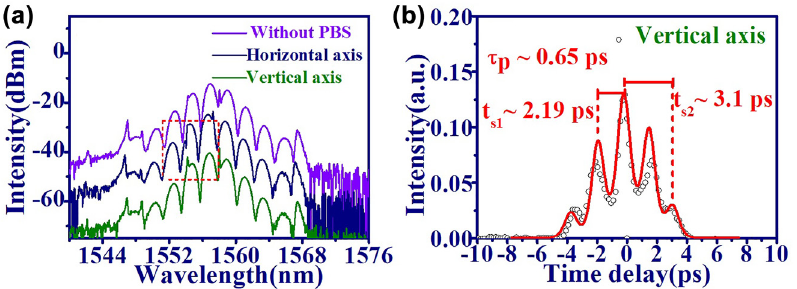
Figure 6: Bound GVLVSs from EDFL based on GO/PVA film. (a) Optical spectrum of (without PBS: purple line, horizontal axis: navy line and vertical axis: green line), (b) IAC trace on the vertical axis (open circle) and theoretical fitting curve (red solid line) by Eqs. (3) and